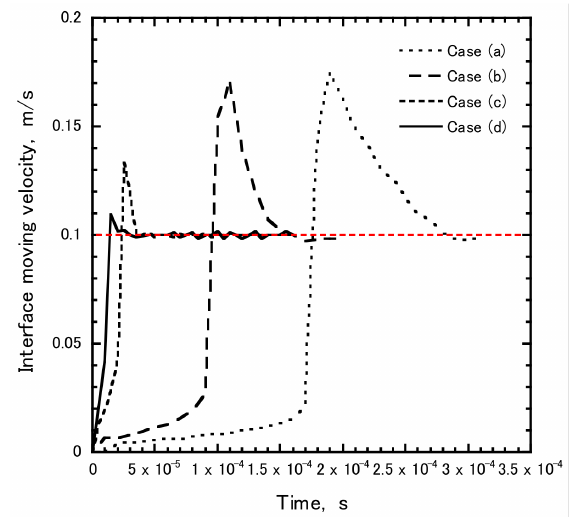
Figure 8. Interface moving velocity with time at ( a ) 5 × 10 5 K/s and 5 × 10 6 K/m, ( b ) 1 × 10 6 K/s and 1 × 10 7 K/m, ( c ) 5 × 10 6 K/s and 5 × 10 7 K/m and ( d ) 1 × 10 7 K/s and 1 × 10 8 K/m, obtained by the quasi-equilibrium MPFM. The red dashed line indicates a steady